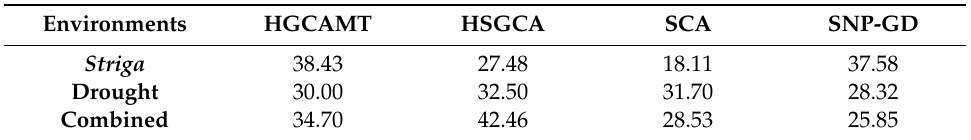
Table 10. E ffi ciencies (%) of heterotic grouping methods in classifying lines into heterotic groups as compared with using discriminant